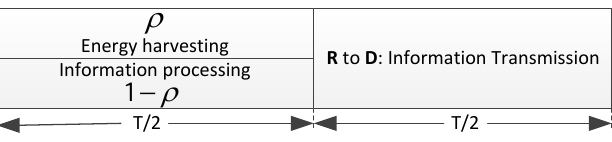
Figure 3. The PS